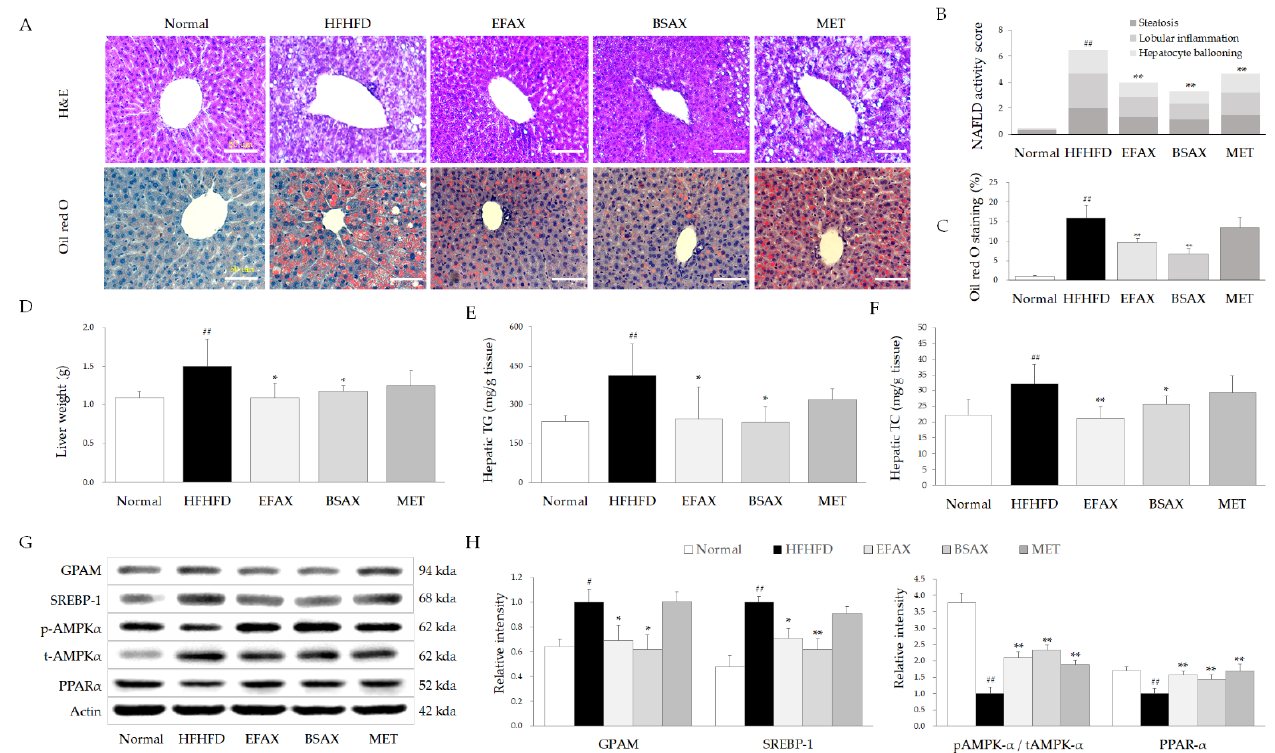
Figure 3. BSAX ameliorated hepatic steatosis by inhibiting lipogenesis. ( A ) Hematoxylin and eosin (H&E) staining and Oil Red O (ORO) staining were carried out on the liver tissues. ( B ) Nonalcoholic fatty liver disease activity scores (NASs) were calculated for comparison. ( C )The area of red in the ORO staining was analyzed using ImageJ v1.8.0 (NIH, Bethesda, MD, USA). ( D ) The livers were removed and weighed immediately at the end of the experimental period. ( E , F ) The hepatic triglyceride (TG) and total cholesterol (TC) levels were measured with a Chemistry Auto Analyzer (Chiron, Emeryville, CA, USA). ( G ) The levels of hepatic lipid-metabolism-associated proteins were assessed by Western blotting. ( H ) ImageJ v1.8.0 was used to quantify the relative intensities of the bands. # p < 0.05, ## p < 0.01, compared with the normal group; * p < 0.05, ** p < 0.01, compared with the HFHFD